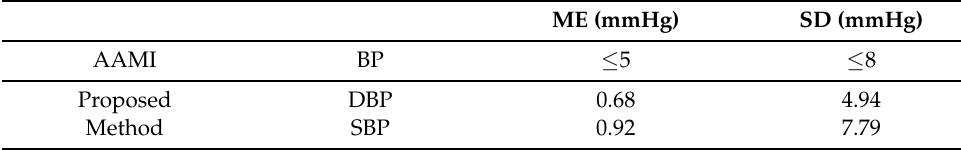
Table 2. Comparison with the AAMI protocol.